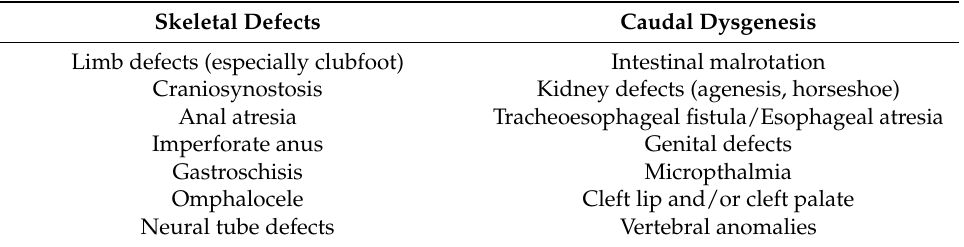
Table 1. Birth defects associated with abnormal laterality in humans